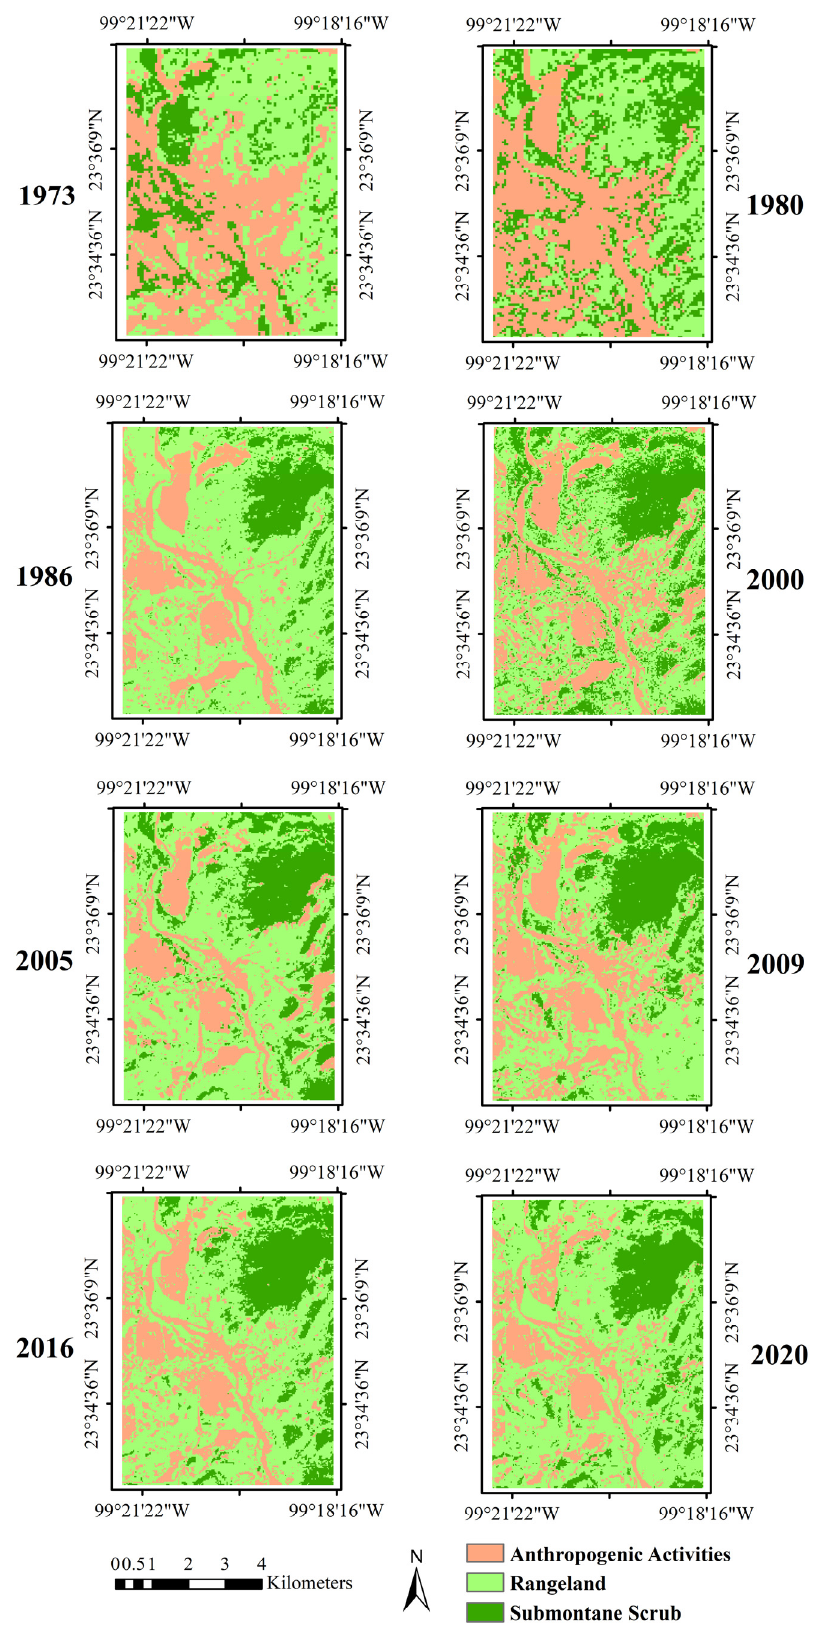
Tamaulipas, Mexico.